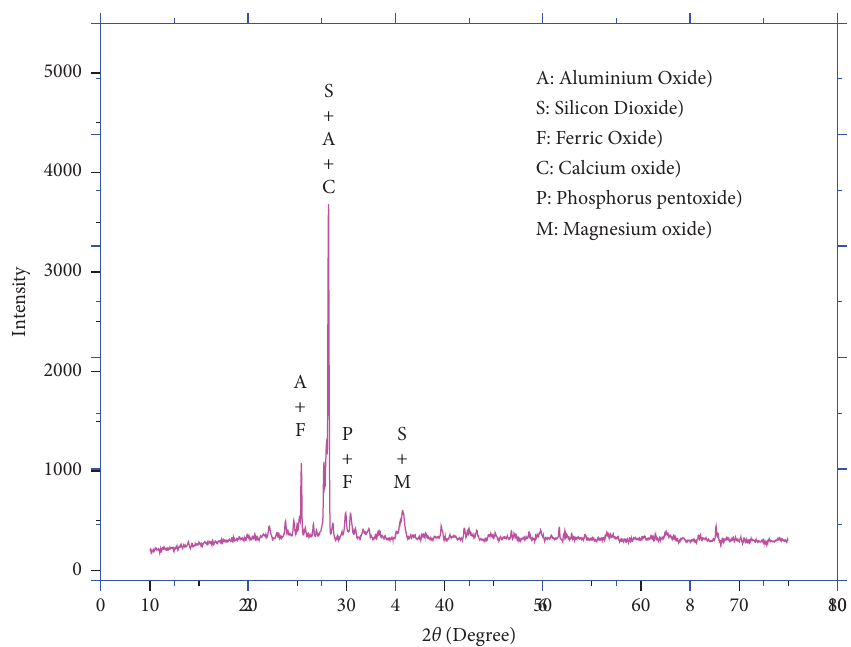
Figure 2: X-ray difraction patterns for the cinder gravel material. Table 3: Chemical compositions of the cinder gravel material. SN Chemical compositions Chemical formulas Weight